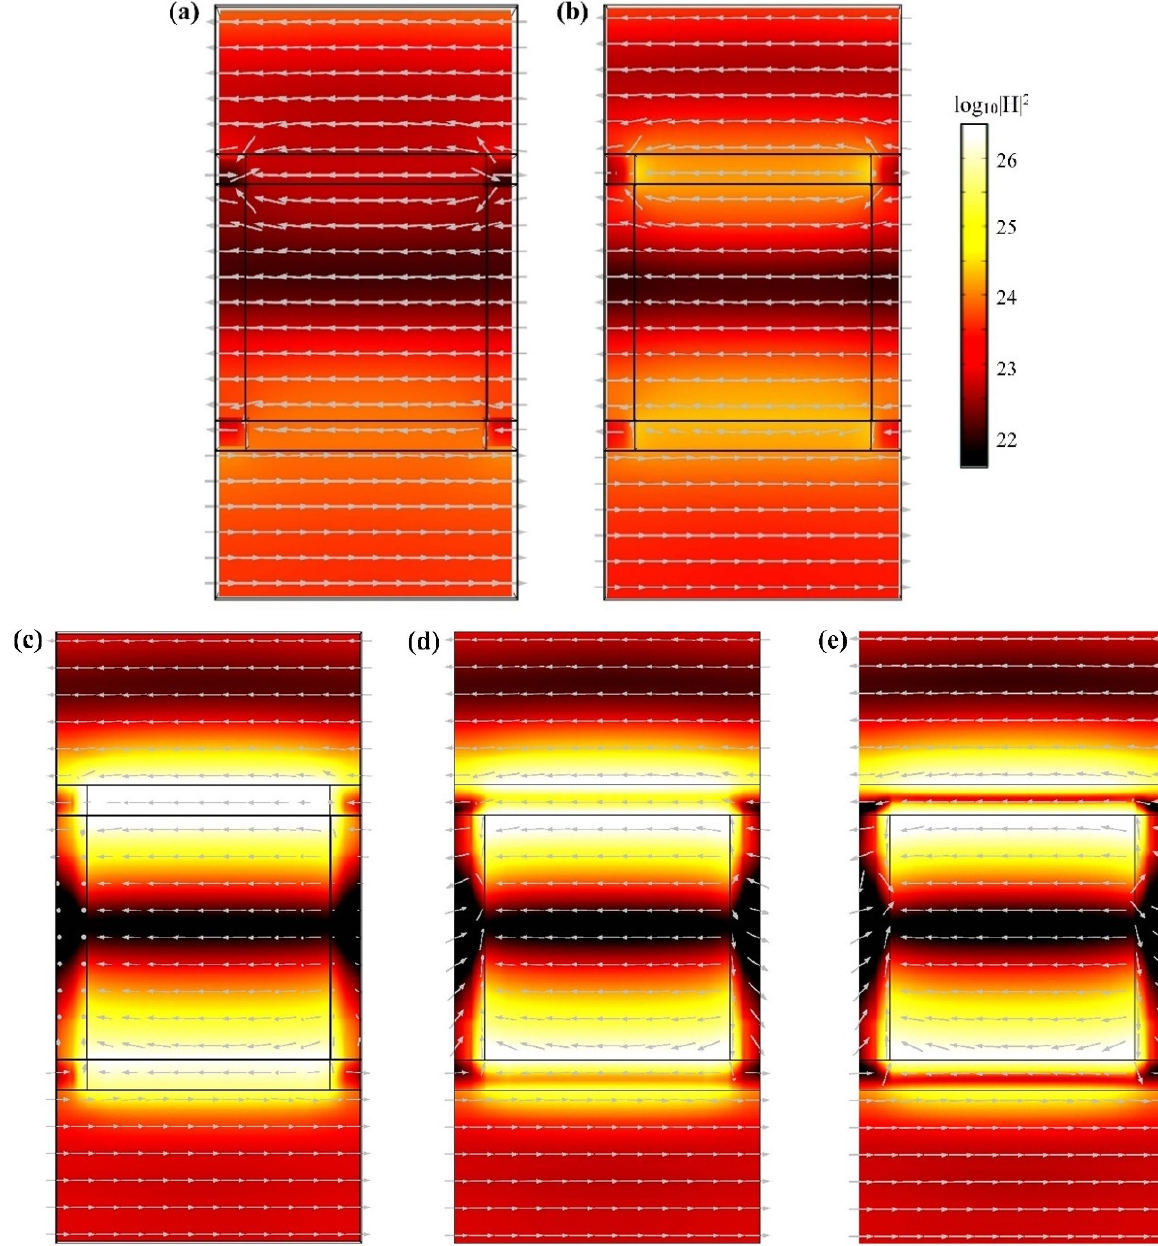
Figure 9. Magnetic and electric fields intensity distribution at the different compute region at the wavelength of 1.425 µm: ( a ) Y = 0 nm, ( b ) Y = 100 nm, ( c ) Y = 200 nm, ( d ) Y = 225 nm, ( e ) Y = 250 nm.